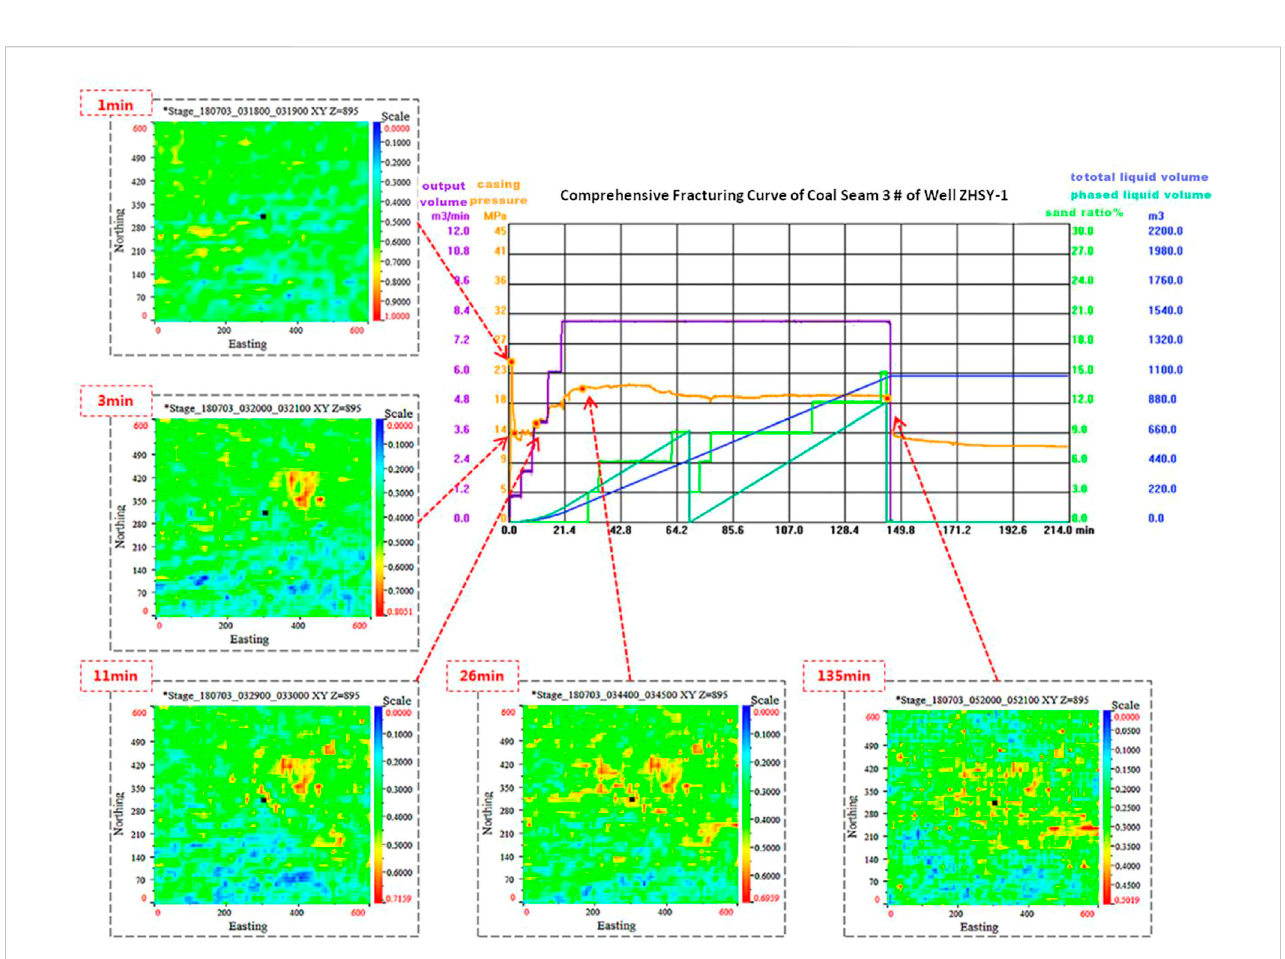
FIGURE 9 Fracturing construction curve and fracture state characteristic